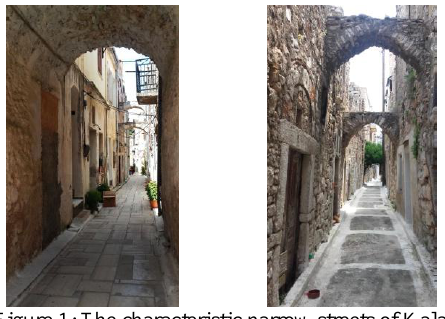
Figure 1: The characteristic narrow streets of